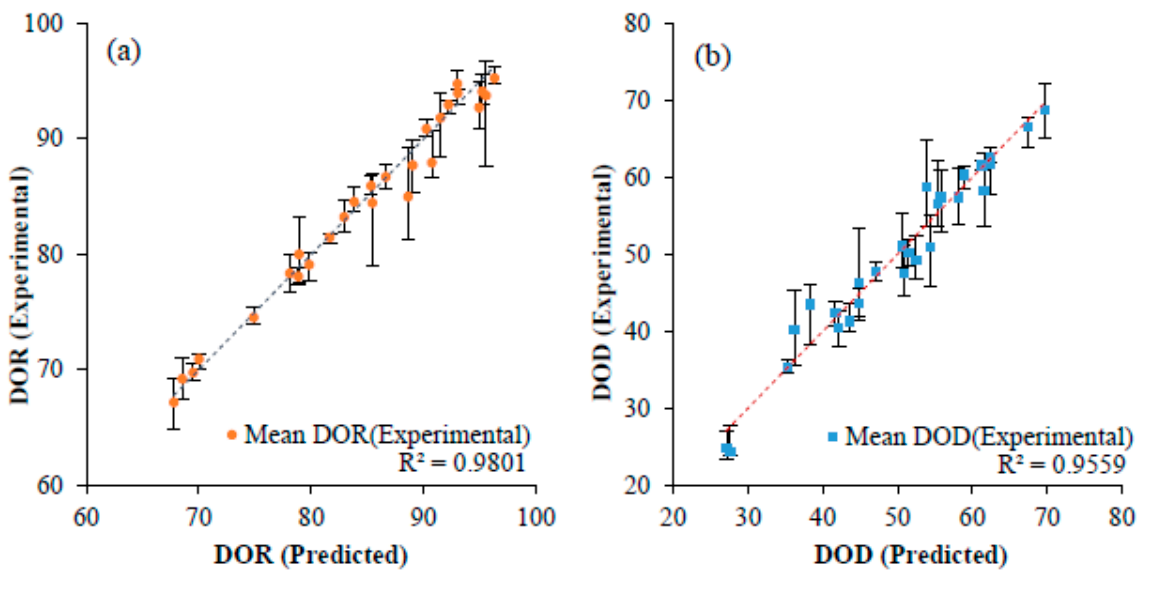
Figure 15. Comparison between experimental and predicted values of ( a ) degree of reduction (DOR) and ( b ) degree of densification (DOD) based on Taguchi experimental analysis.